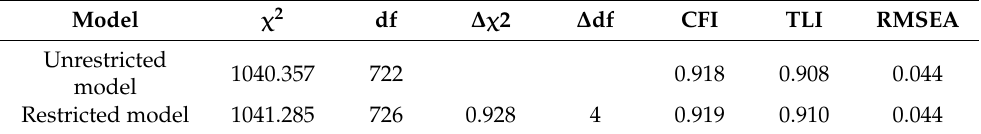
Table 9. Testing the moderating effect of the participant’s closest colleagues being in the same team.